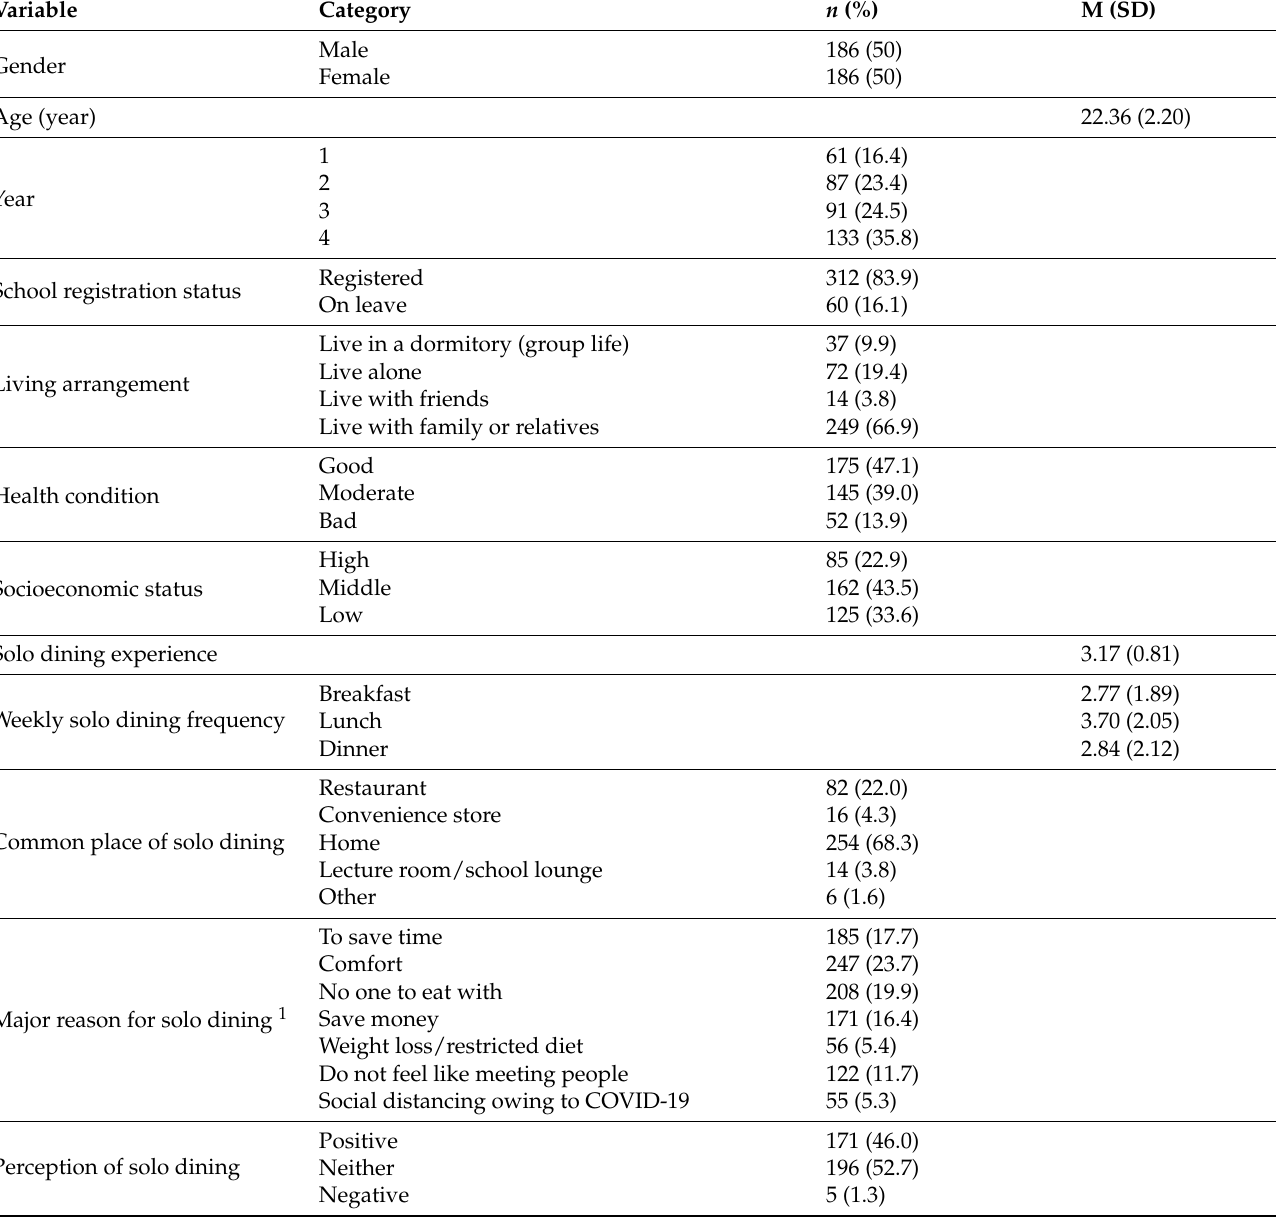
Table 1. Participants’ general and solo dining-related characteristics ( n =